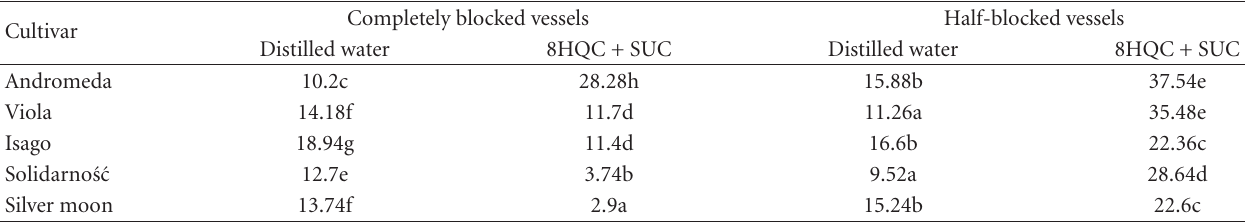
Table 4: Average number of blocked vessels (in percent) in Clematis stems stored in distilled water and 8HQC with 2% sucrose, term II. Completely blocked vessels Half-blocked vessels Cultivar Distilled water 8HQC + SUC Andromeda